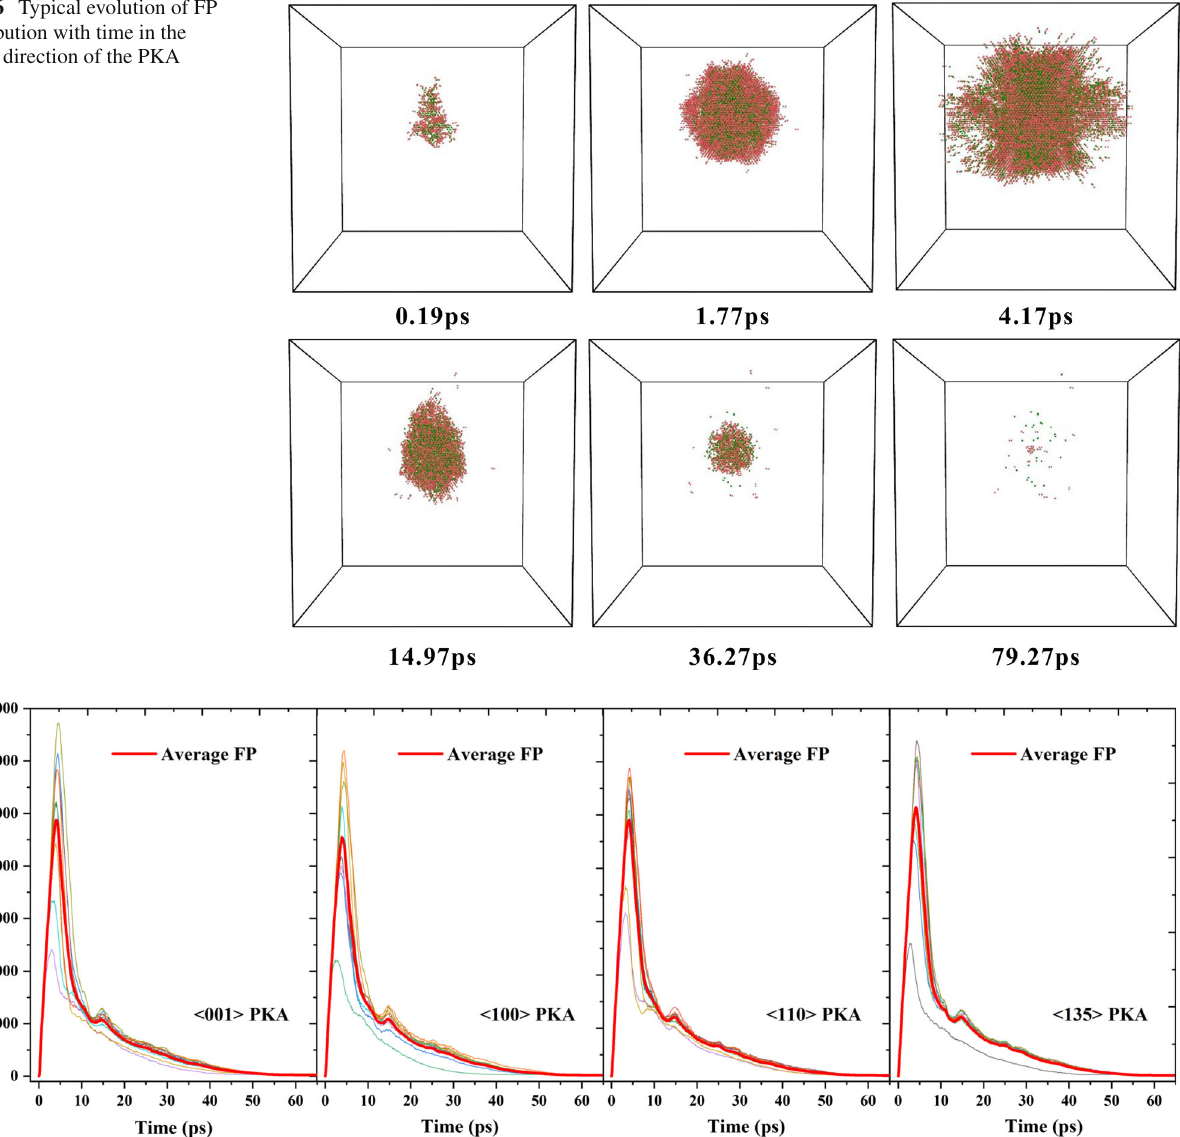
Fig. 7 Evolution of the FP number with time during the PKA cascade collision of the 10 keV kinetic energy in the metal